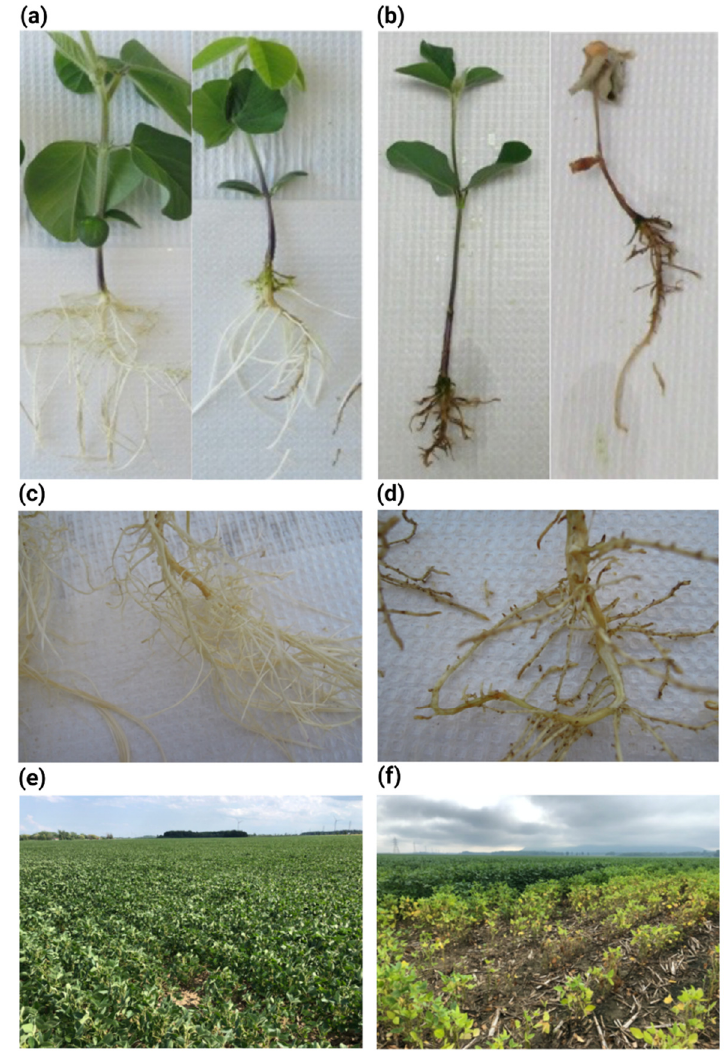
Figure 1. Disease symptoms of Phytophthora sojae on soybean. Illustrations of ( a ) control seedlings and ( b ) infected seedlings and ( c ) a closer look at healthy roots and ( d ) rotten roots. Typical soybean field showing ( e ) healthy and ( f ) infected plants. field showing ( e ) healthy and ( f ) infected